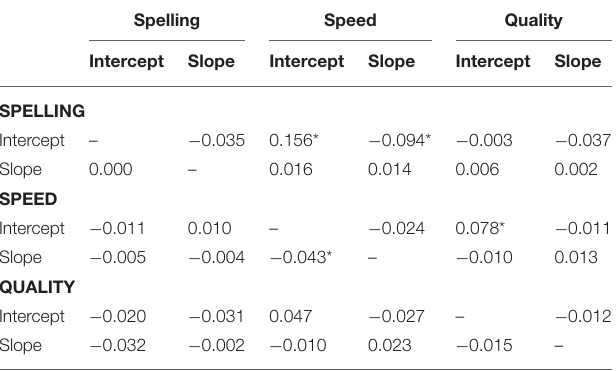
TABLE 7 | Correlation coefficients at the individual level between growth factors of spelling, handwriting speed, and handwriting quality in cohort 1 and cohort